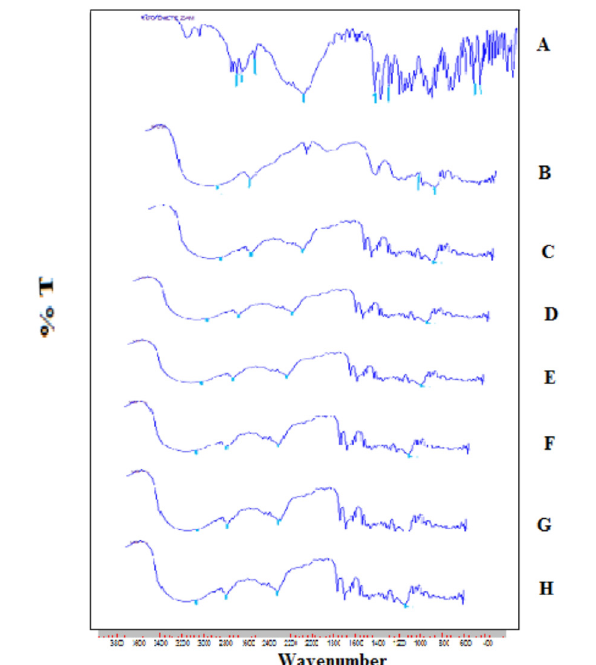
FIGURE 3 - Infrared spectroscopy study.